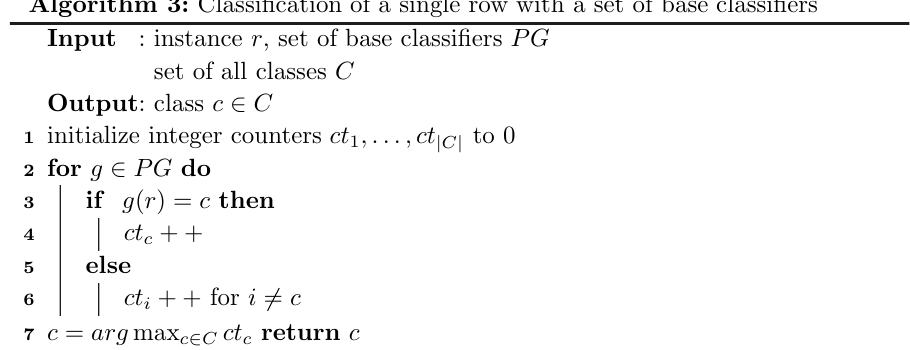
Algorithm 3: Classification of a single row with a set of base